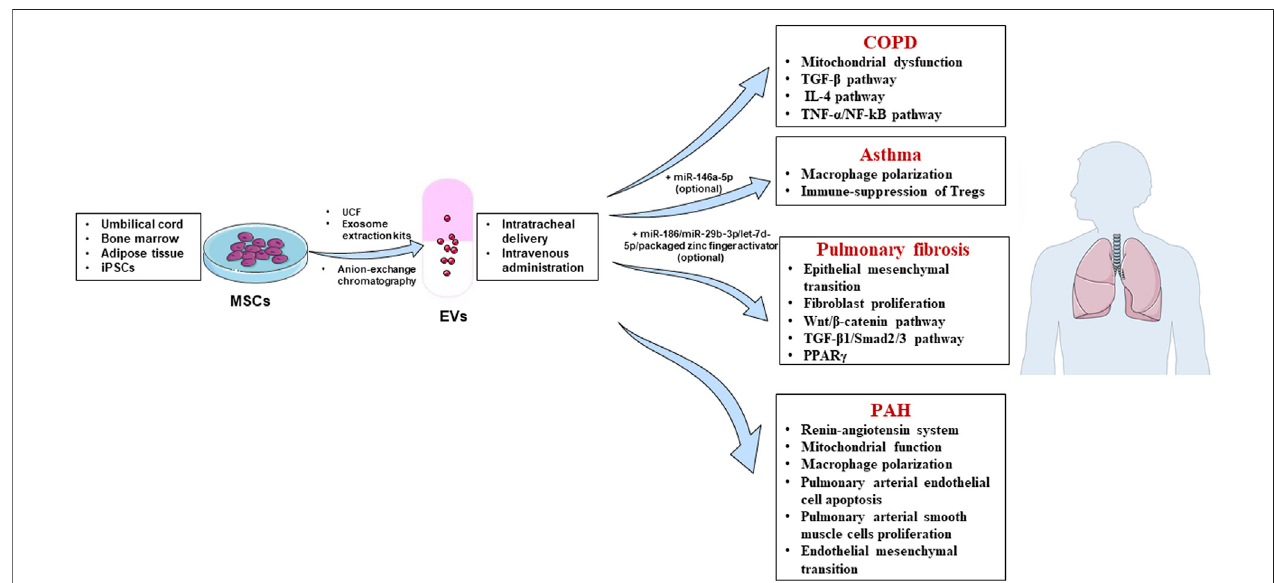
FIGURE 1 | Mechanisms of mesenchymal stem cell-derived extracellular vesicles (MSC-EVs) in treating chronic respiratory diseases. Sources of MSC-EVs: umbilicalcord,bonemarrow,adiposetissueandinducedpluripotentstemcells(iPSCs);Isolationmethods:ultracentrifugation(UCF),exosomeextractionkitsandanion- exchange chromatography; Treatment routes: intratracheal delivery and intravenous administration; Diseases: chronic obstructive pulmonary disease (COPD), asthma, pulmonary fi brosis and pulmonary arterial hypertension (PAH).